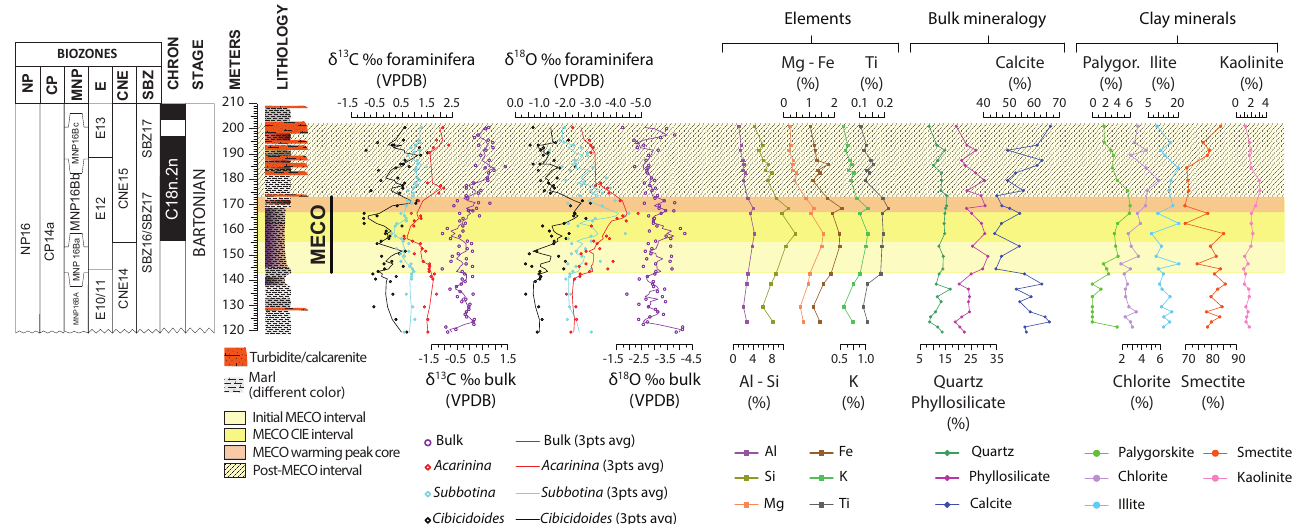
Figure 2. Magnetobiostratigraphy, lithological log, and stable isotopes curves of the Baskil section from [3,33]. Calcareous nannofossil zones and subzones after [34] (listed as NP), [35] (listed as CP), [36] (listed as MNP), and [37] (listed as CNE). Planktic foraminiferal zones are after [38] (listed as E). Larger benthic foraminiferal zones and subzones are after [39,40]. Carbon ( δ 13 C) and oxygen ( δ 18 O) isotopes are shown for three individual genera of foraminifera, representing surface ( Acarinina ), thermocline ( Subbotina ) and bottom ( Cibicidoides ) conditions. Diamonds represent individual data points, whereas solid lines represent curves smoothed by three-point-moving average. The record of elements, bulk mineralogy and clay minerals is from [32]. The colored bands highlight the five identified